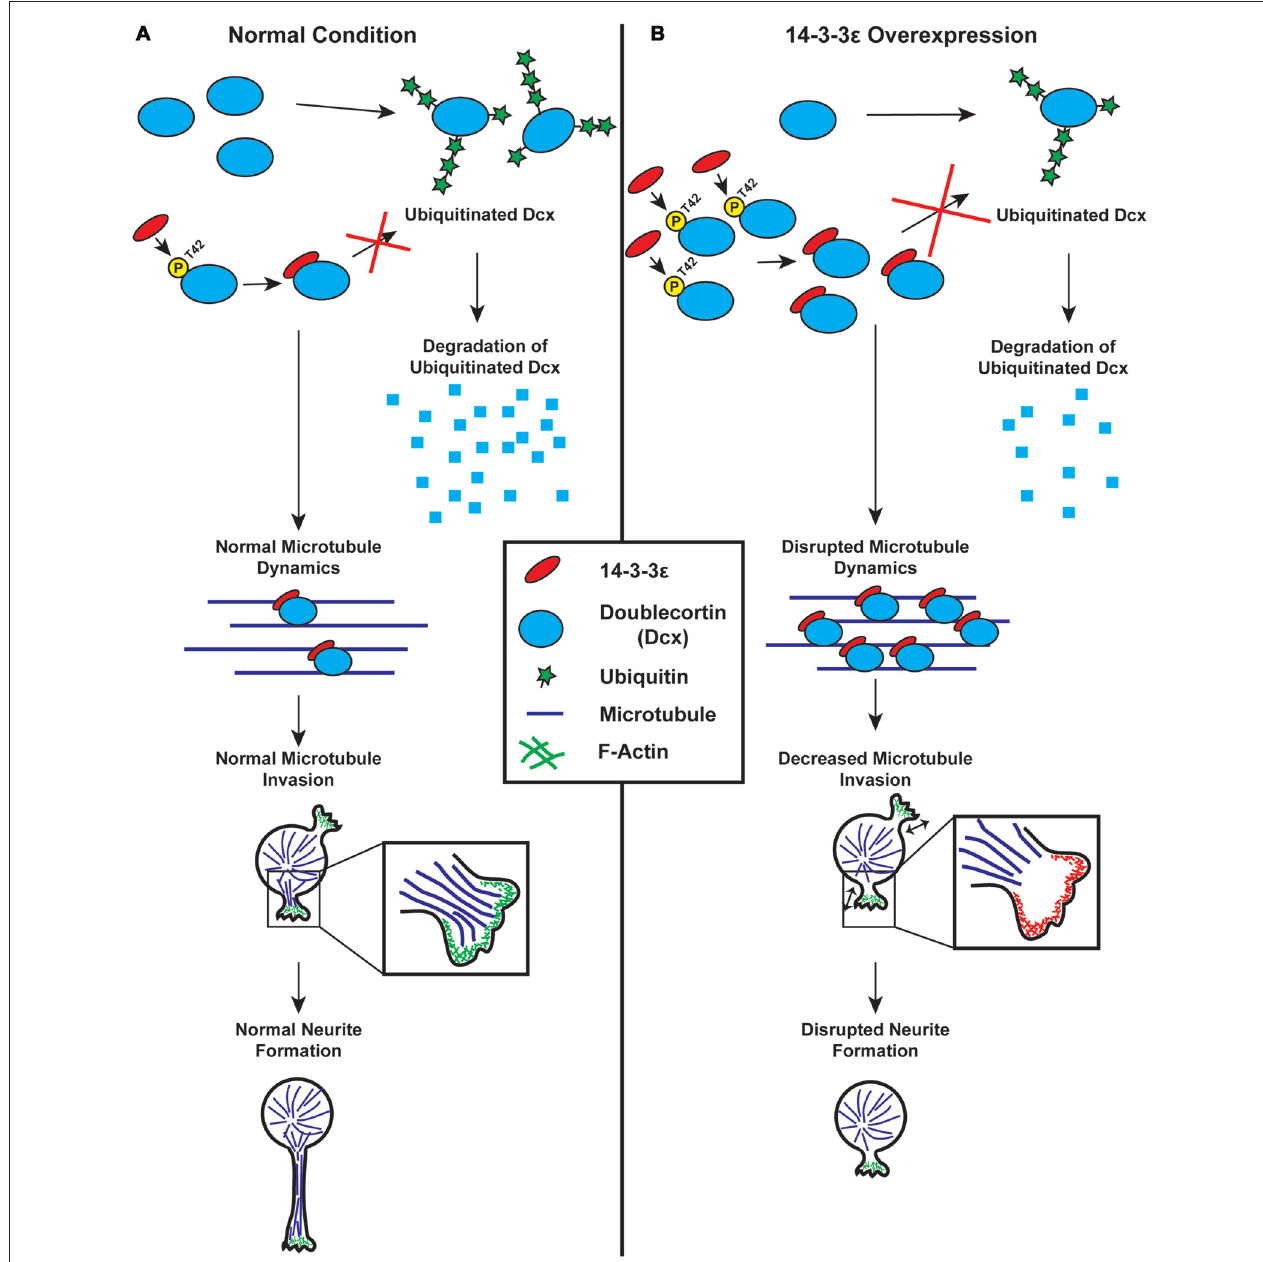
FIGURE 5 | Schematic illustration of the regulation of neurite initiation by 14-3-3 ε during cortical development. (A) Under normal conditions, 14-3-3 ε binds to doublecortin (Dcx) at phosphorylated threonine-42 (P-T42). The remaining Dcx that is not bound to 14-3-3 ε is rapidly ubiquitinated and subsequently degraded. Dcx stabilized by 14-3-3 ε will then bind to microtubules, allowing for normal microtubule dynamics. During neurite initiation, microtubules are able to enter and stabilize lamellipodia allowing for normal neurite initiation. (B) When 14-3-3 ε is overexpressed, there is increased binding of 14-3-3 ε to Dcx, preventing its ubiquitination and subsequent degradation, resulting in an increase in Dcx protein levels. The increased Dcx binds to microtubules in excess, and this disrupts normal microtubule dynamics. This prevents microtubules from invading lamellipodia type structures during neurite initiation thus inhibiting normal neurite